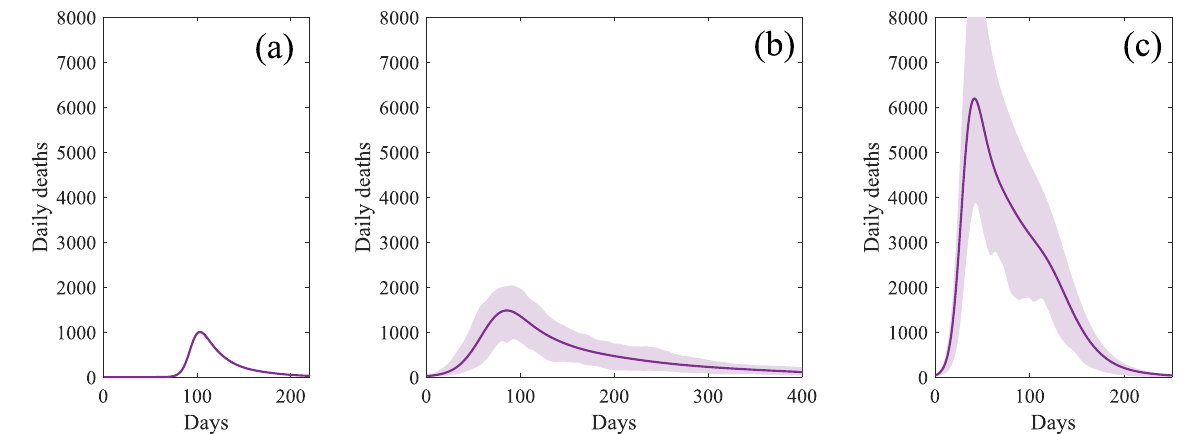
Fig 4. Simulated daily deaths without vaccination. (a) First wave of infection as observed from the start of 2020. (b) Subsequent wave of infection following relaxation to limited NPIs, sufficient to reduce the basic reproductive number to approximately R = 1.8( ± 0.1). (c) Subsequent infection wave following complete relaxation of all NPIs leading to R = 2.3( ± 0.2). Uncertainty is represented by the shaded region, within which 95% of simulations are found to fall.